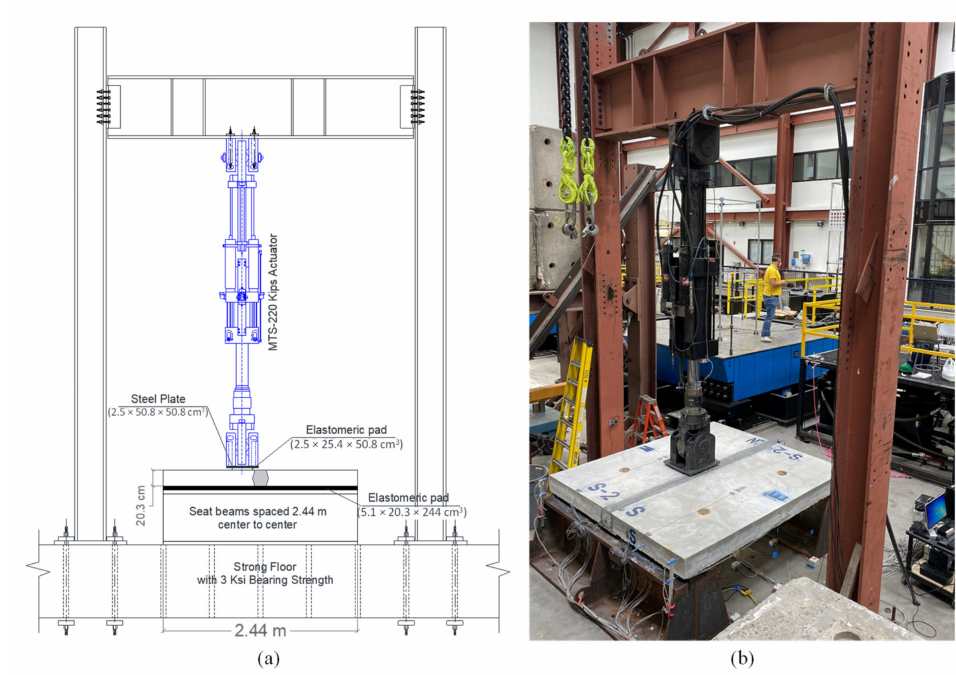
Figure 4. Experimental test setup ( a ) schematic drawing of the test setup; ( b ) photograph of the actual test setup at